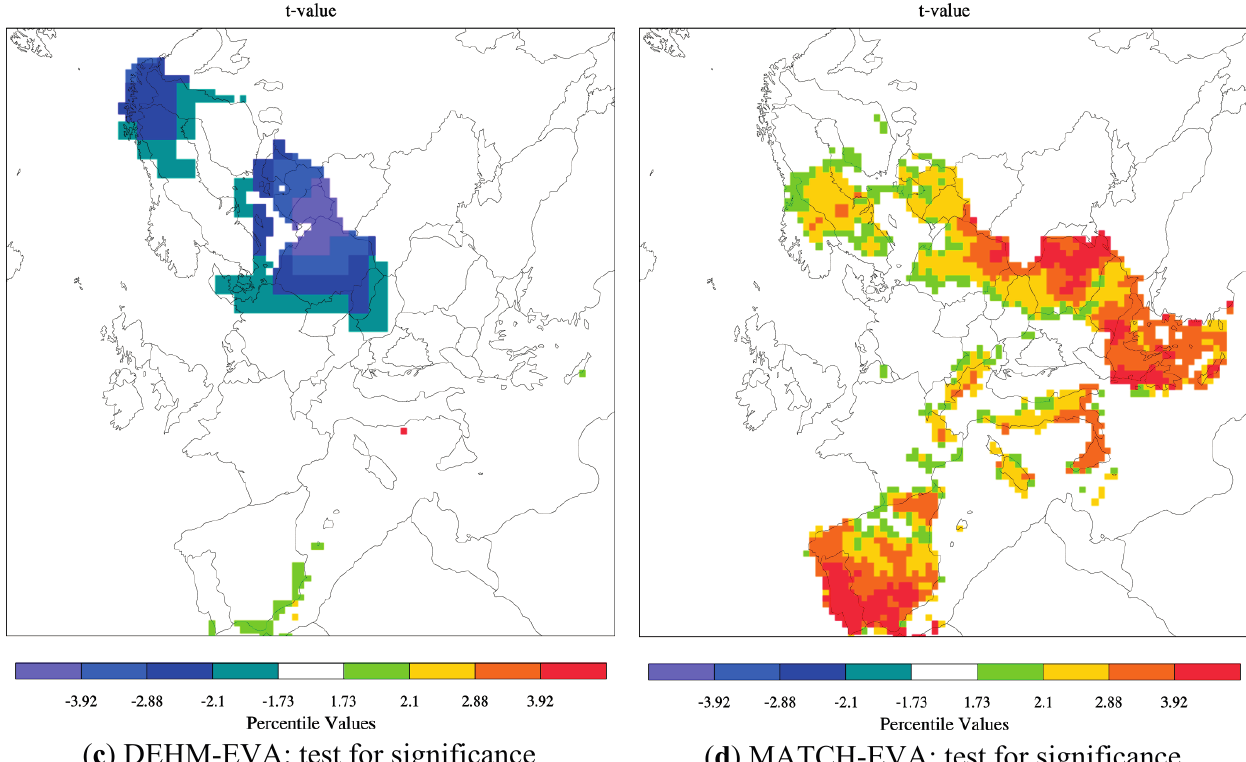
Figure 8. Climate change alone: change (absolute difference) in chronic mortality from present (2000s) to future (2080s) as estimated by DEHM-EVA ( a ) and MATCH-EVA ( b ). The colour bar refers to number of cases per year per 2500 km 2 . The change has been tested for significance and the corresponding t -value is given below ( c and d ) for each model. Only in areas with a colour different from white the estimated difference is significant. The threshold value for significance is chosen to